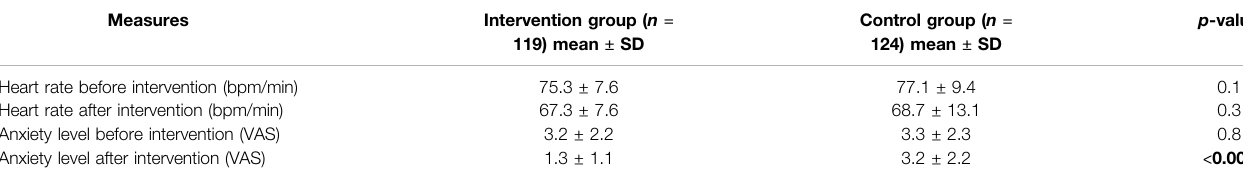
TABLE 2 | Heart rate and anxiety level in the music intervention and in the control group.